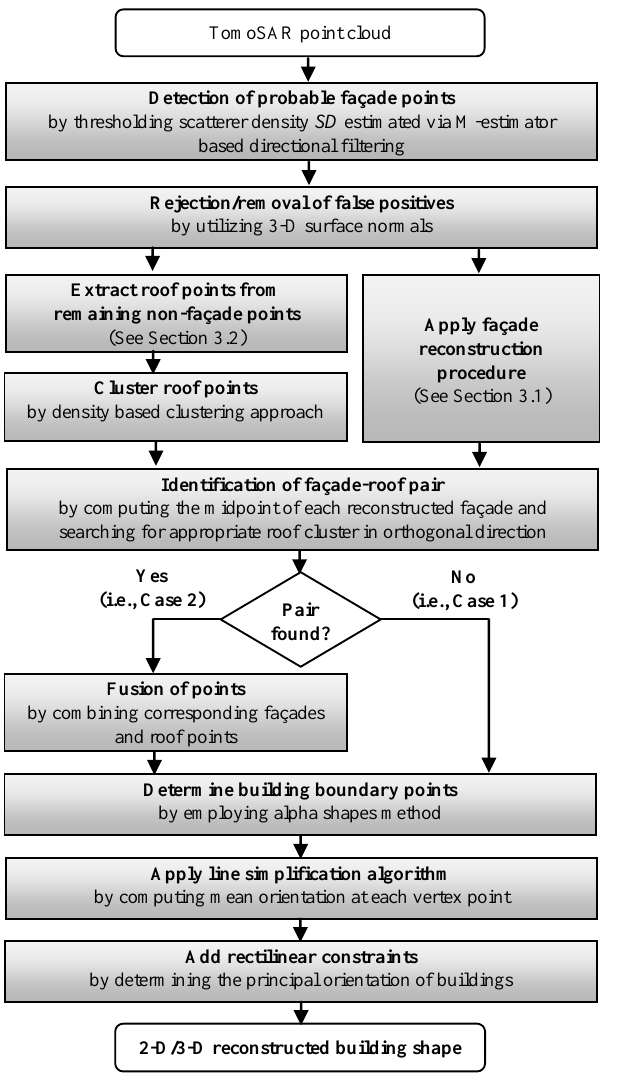
Figure 1: Block diagram of the proposed